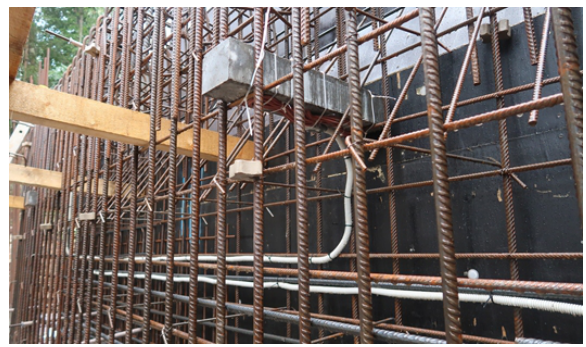
Figure 3. Installed casing beam with thermometers in abutment shaft. Cables are led along reinforcement rods for protection before damage during concreting of abutment